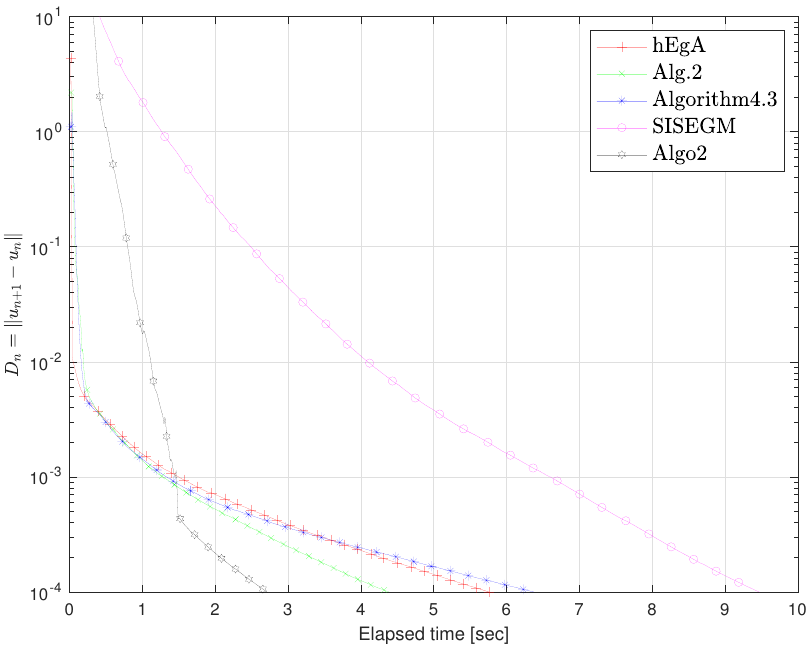
Figure 12. Example 1 in R 5 : Elapsed time 5.76, 4.38, 6.37, 9.47, 2.71 respectively.